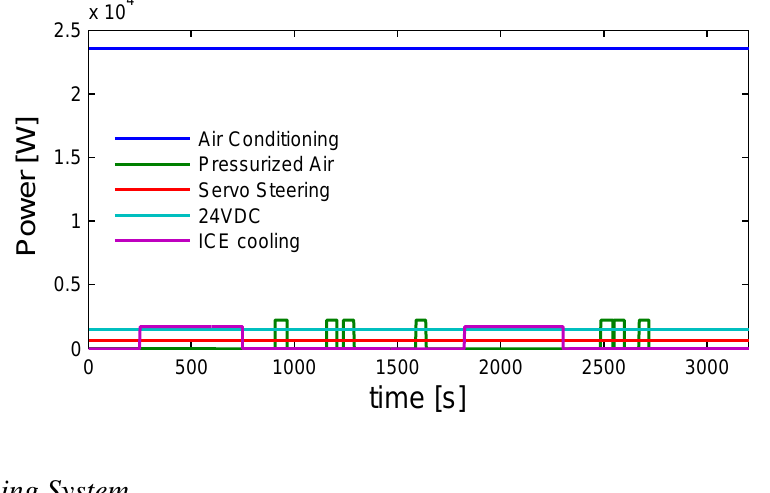
Figure 6. Power consumption of the ancillaries for the HEV with air conditioning turned